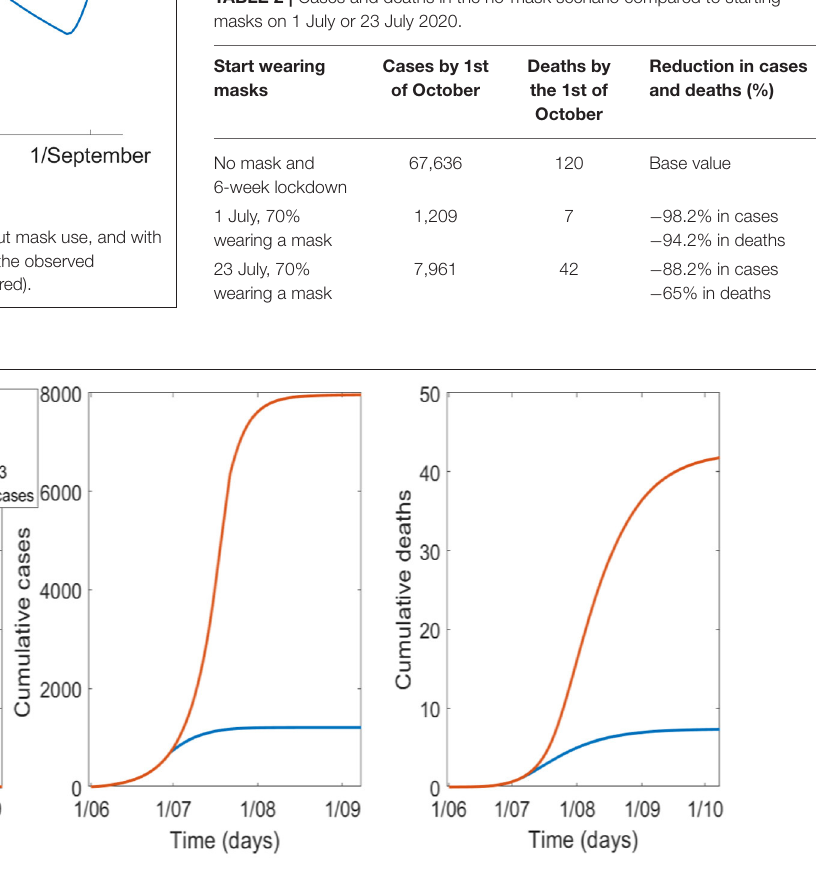
FIGURE 2 | The effect of the timing of universal mask use with a 6-week lockdown and 70% uptake, starting on 1 July or 23 July in Victoria.